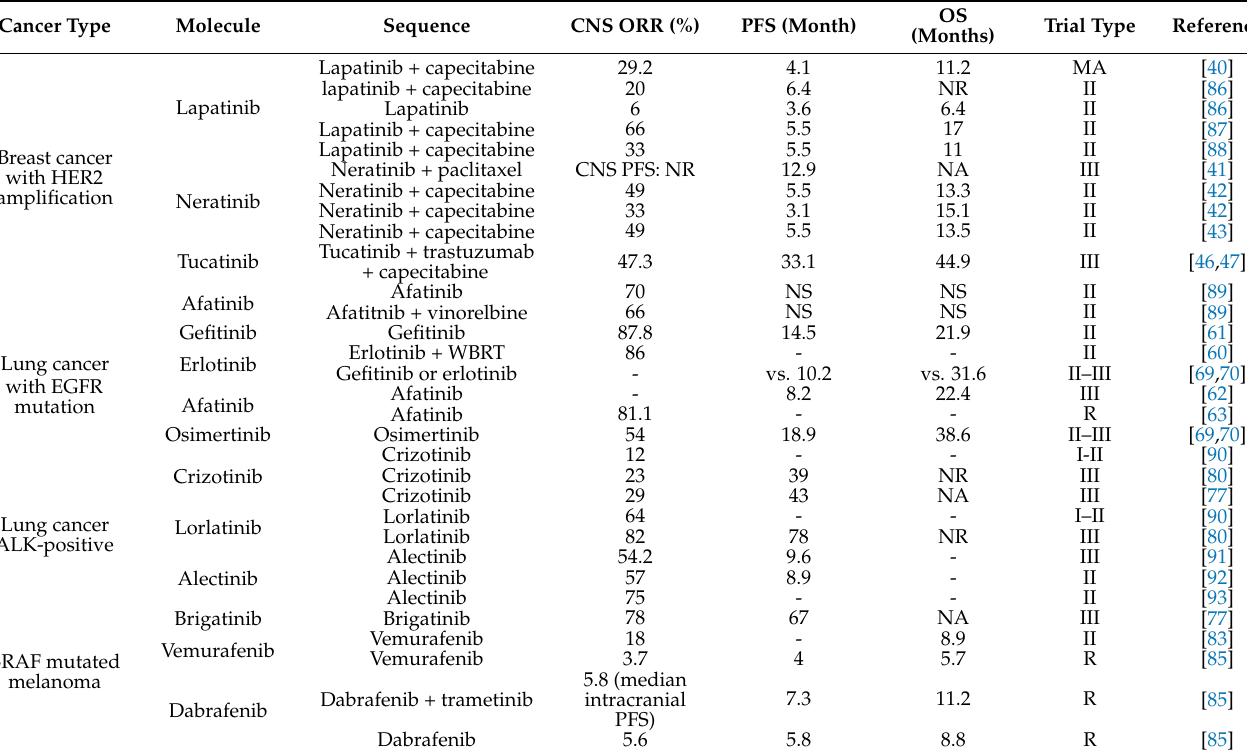
Table 1. Clinical trials on TKIs in different cancer types with brain metastases.